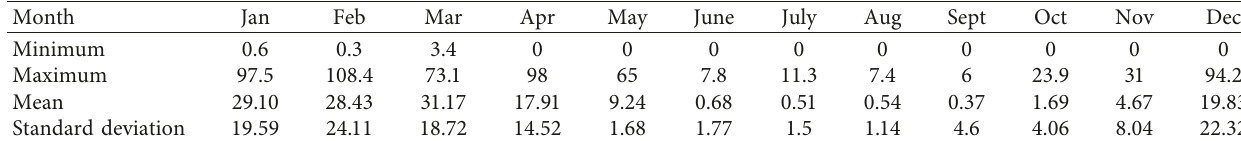
Figure 1: Location map of study area in the southeast of Table 1: Statistical characteristics of monthly precipitation (1961–2005).